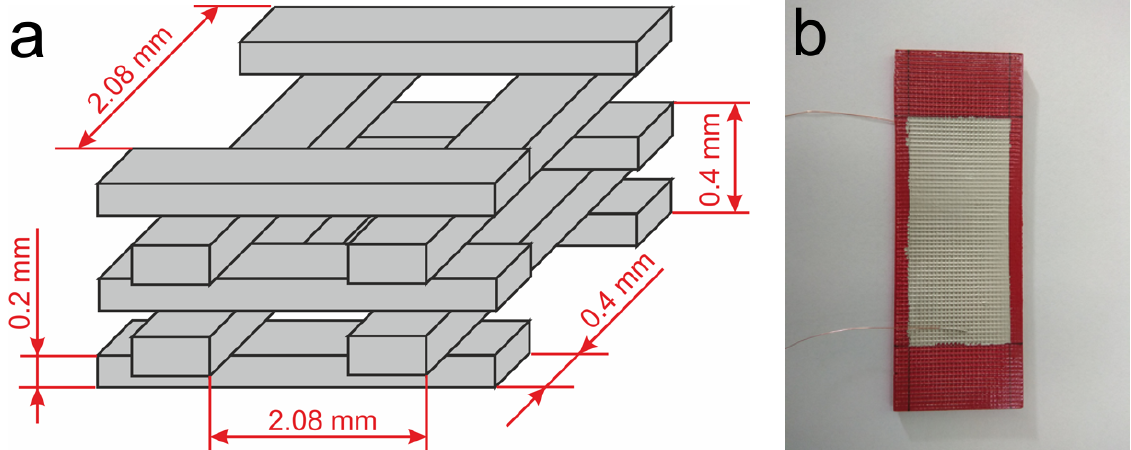
Figure 7. ( a ) Diagram showing the configuration of a single “cell” of a printed skeleton grid (with the dimensions pro- vided) and ( b ) a photograph of the grid filled with epoxy resin/SbSI composite and the deposited silver electrodes.